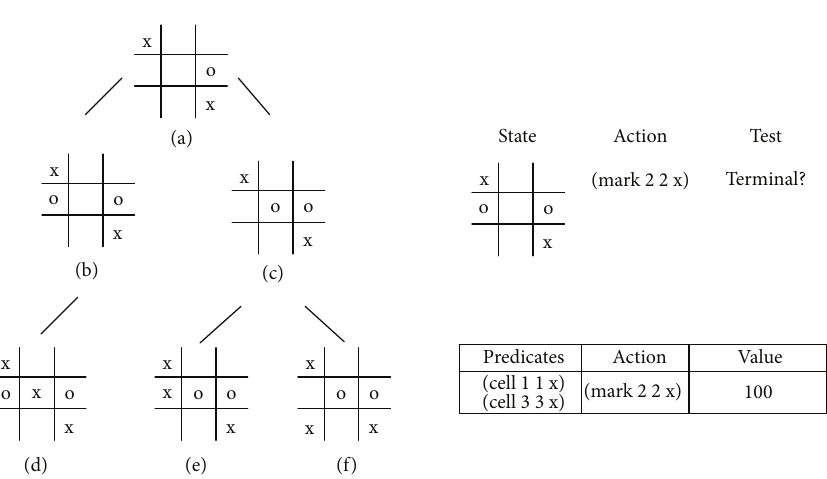
Figure 2: Game Independent Feature Learning. The figure was reproduced based on